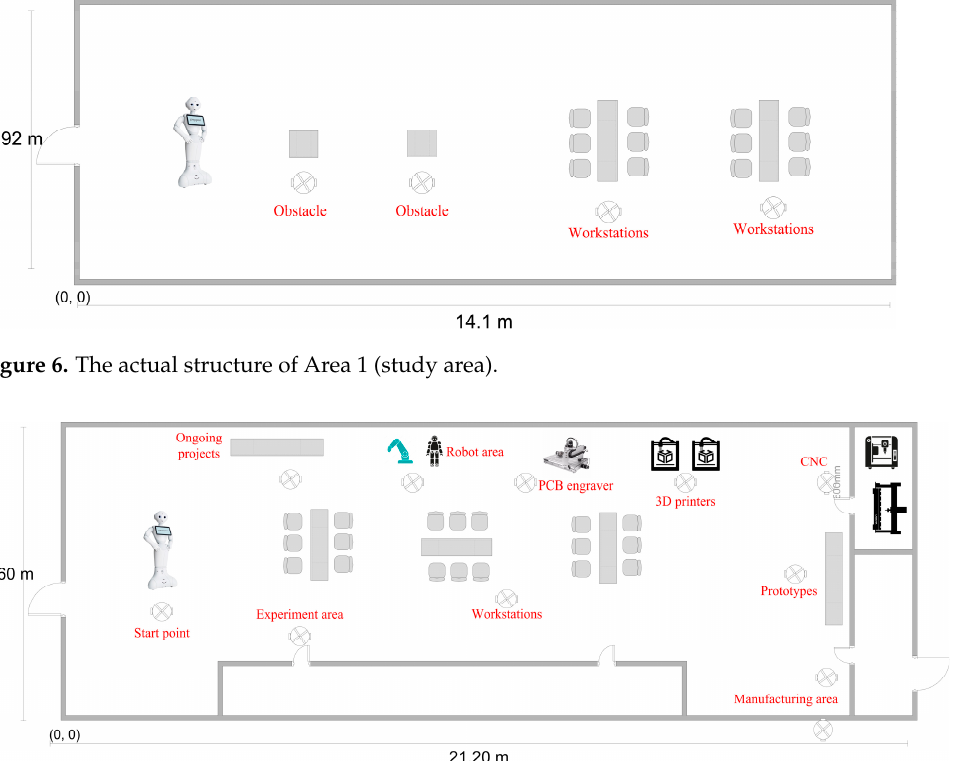
Figure 7. The actual structure of Area 2 (IIRC lab), along with predefined station points.